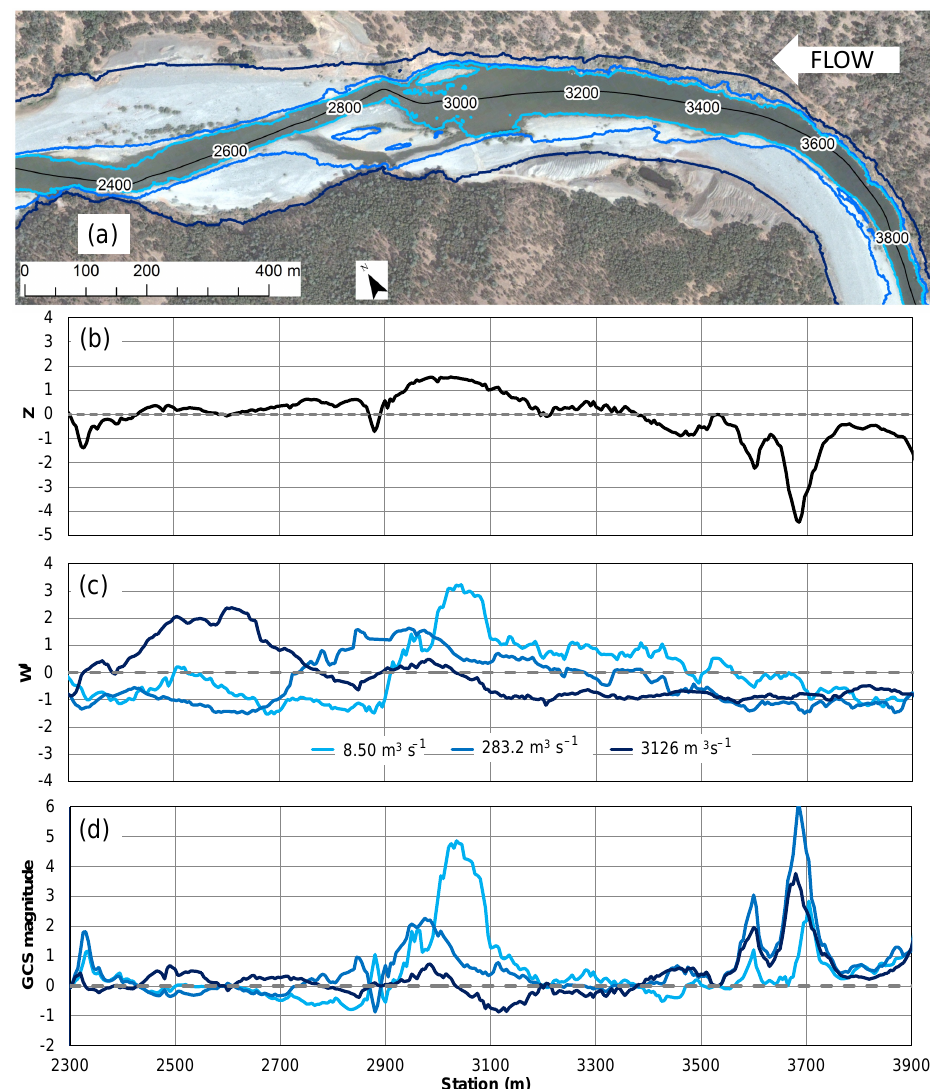
Figure 5. Example section at the lower extent of the study area showing inundation extents (a) . Below are plots of minimum bed elevation (b) , flow widths for 8.50, 283.2, and 3126m 3 s − 1 ( C ), and C 28 September